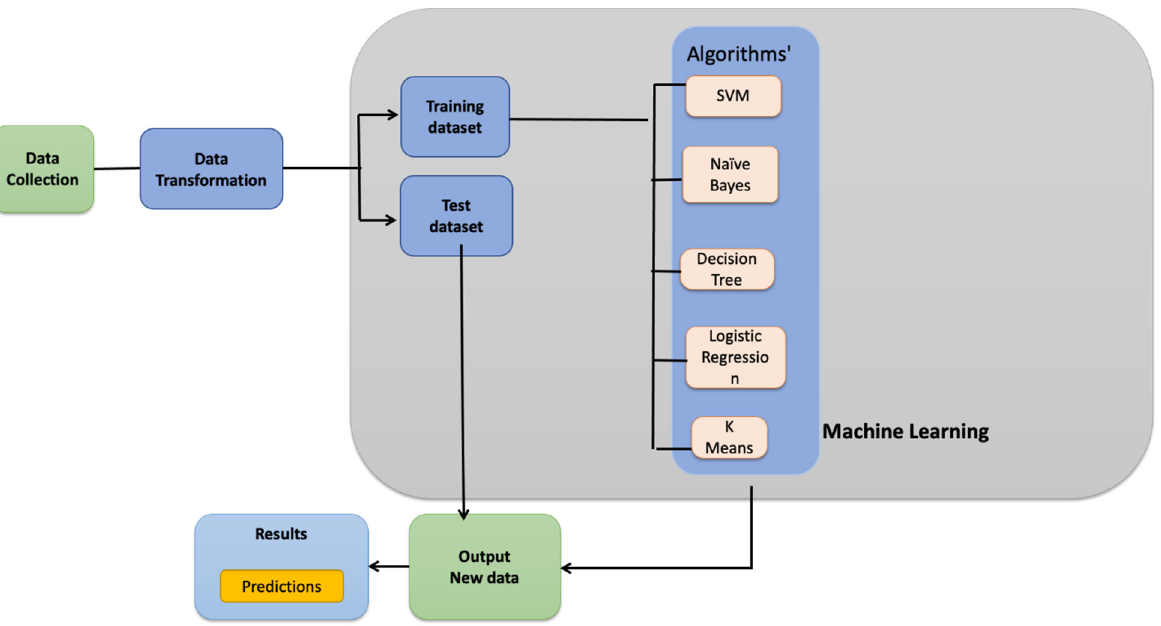
Figure 1. Machine Learning pipeline used for our analysis.